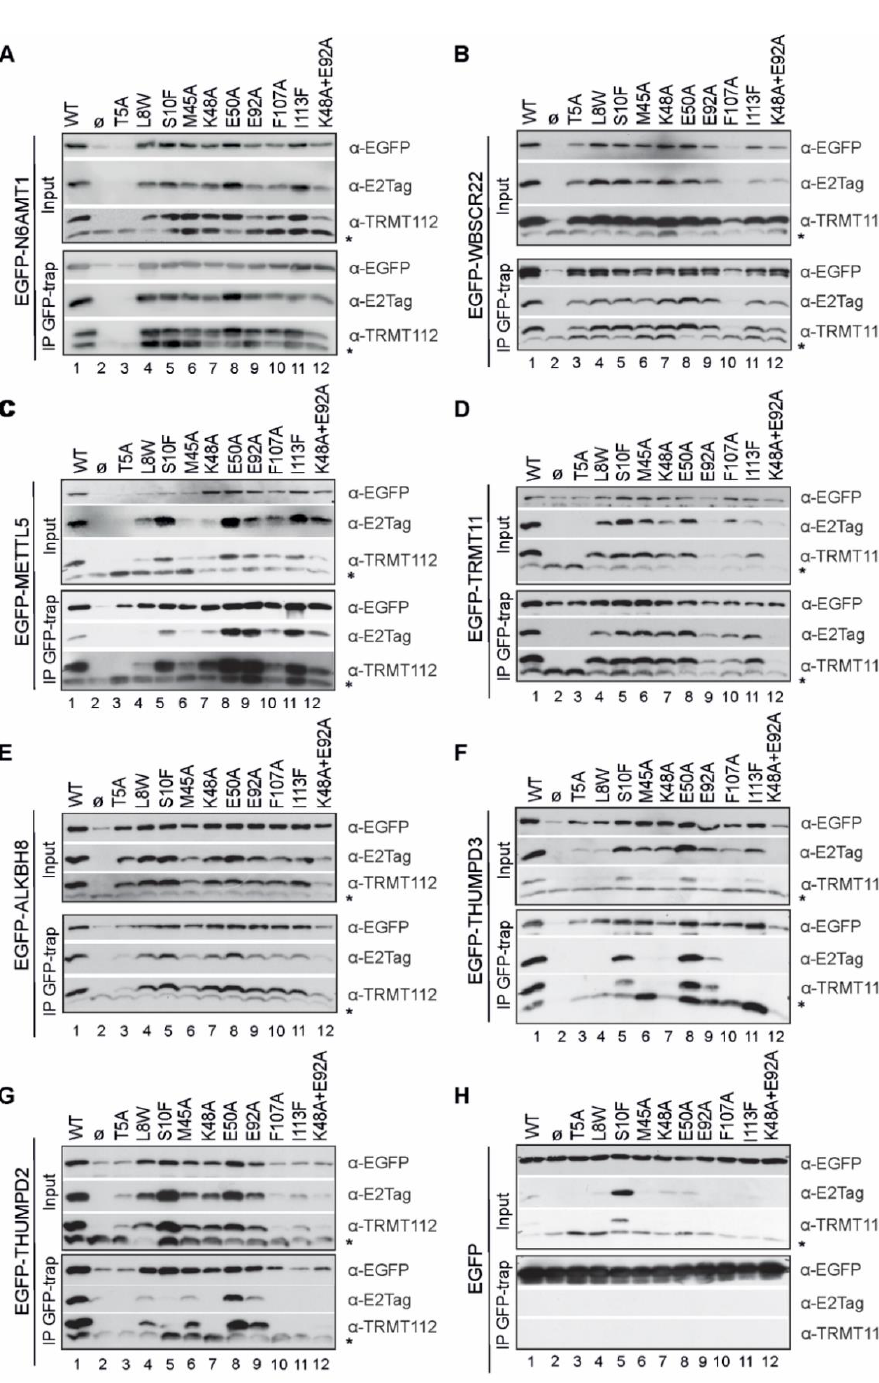
Figure 5. TRMT112 single amino acid mutant interactions with MTases confirm similarities, but also reveal differences in the way TRMT112 interacts with its partners. U2OS cells were transfected with plasmids encoding for EGFP-tagged N6AMT1 ( A ), WBSCR22 ( B ), METTL5 ( C ), TRMT11 ( D ), ALKBH8 ( E ), THUMPD3 ( F ), THUMPD2 ( G ) and EGFP ( H ), along with plasmids encoding for wt or mutated E2Tag-containing TRMT112. Immunoprecipitation was performed with GFP-Trap beads 48 h later using EGFP-tagged MTase as a bait, and samples were subsequently analysed using Western blot. Upper three images of A-H panel represent input of total soluble cell lysate, whereas lower three images represent immunoprecipitated material. Both sections were analysed using antibodies against EGFP, E2Tag and TRMT112. Images of results with anti-TRMT112 depict both recombinant (upper band) and endogenous (lower band marked with asterisk *) protein.